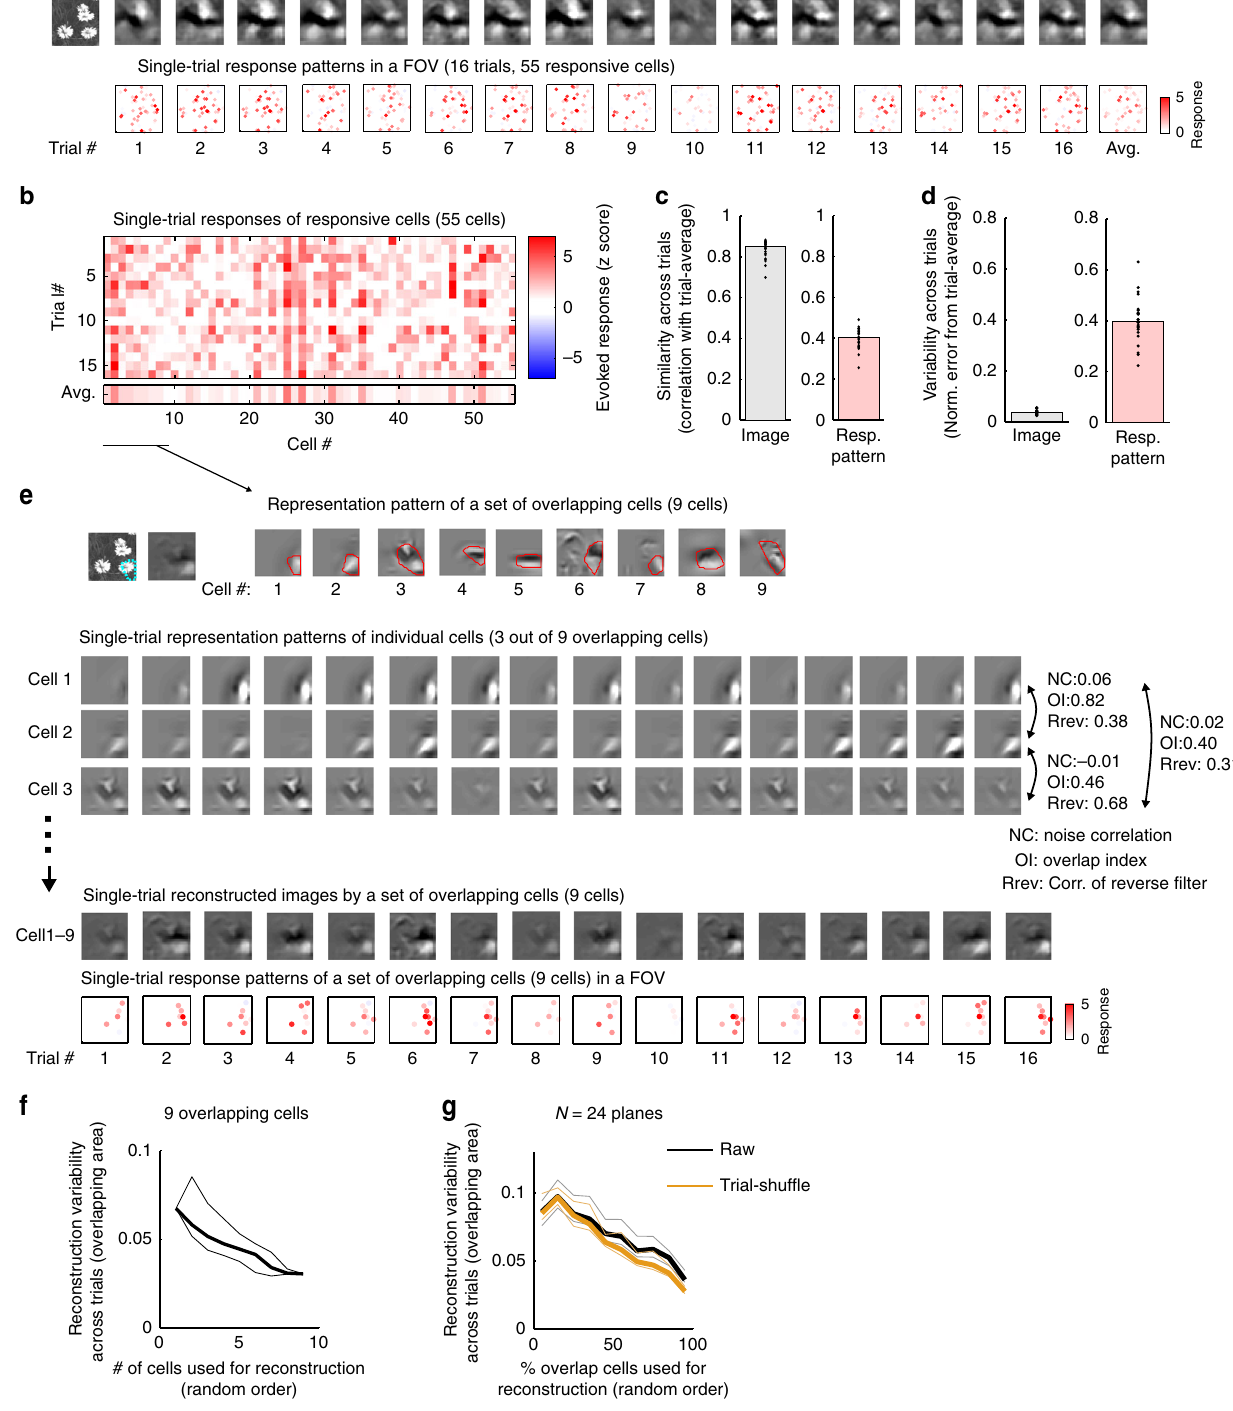
Visual stimulation . Before beginning the recording session, the retinotopic posi- tion of the recorded FOV was determined using moving grating patches (lateral or upper directions, 99.9% contrast, 0.04 cycle/degrees, 2 Hz temporal frequency, 20 and 50 degrees in diameter), while monitoring the changes in signals over the entire FOV. The lateral or upper motion directions of the grating were used to activate many cells because the preferred directions of mouse V1 neurons are slightly biased toward the cardinal directions 54,55 . First, the grating patch of 50 degrees in diameter was presented in 1 of 15 (5 ×3) positions that covered the entire monitor to roughly determine the retinotopic position. Then, the patch of 20 degrees in diameter was presented on the 16 (4 ×4) positions covering an 80 ×80- degree space to fi nely identify the retinotopic position. The stimulus position that